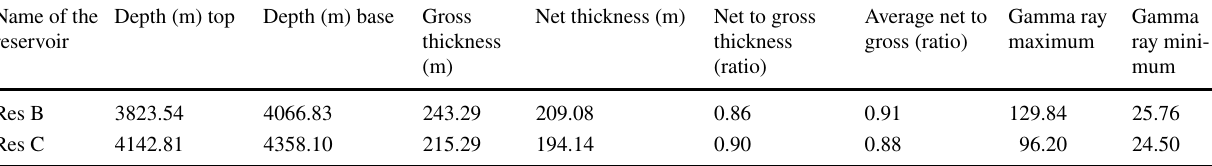
Table 1 Reservoir depth and parameter values used to estimate petrophysical parameters Name of the reservoir